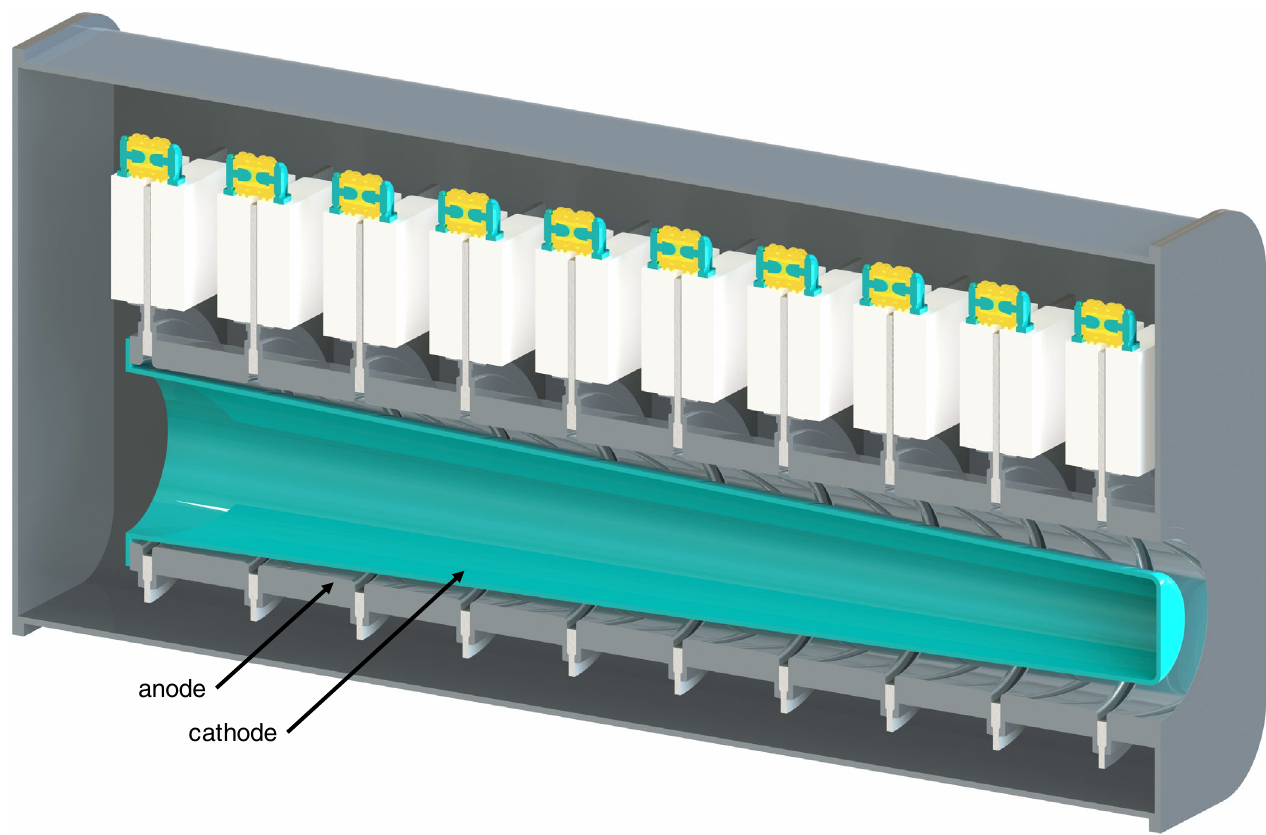
FIG. 11. Cross-sectional view of a ten-stage impedance-matched Marx generator (IMG) with a single brick per